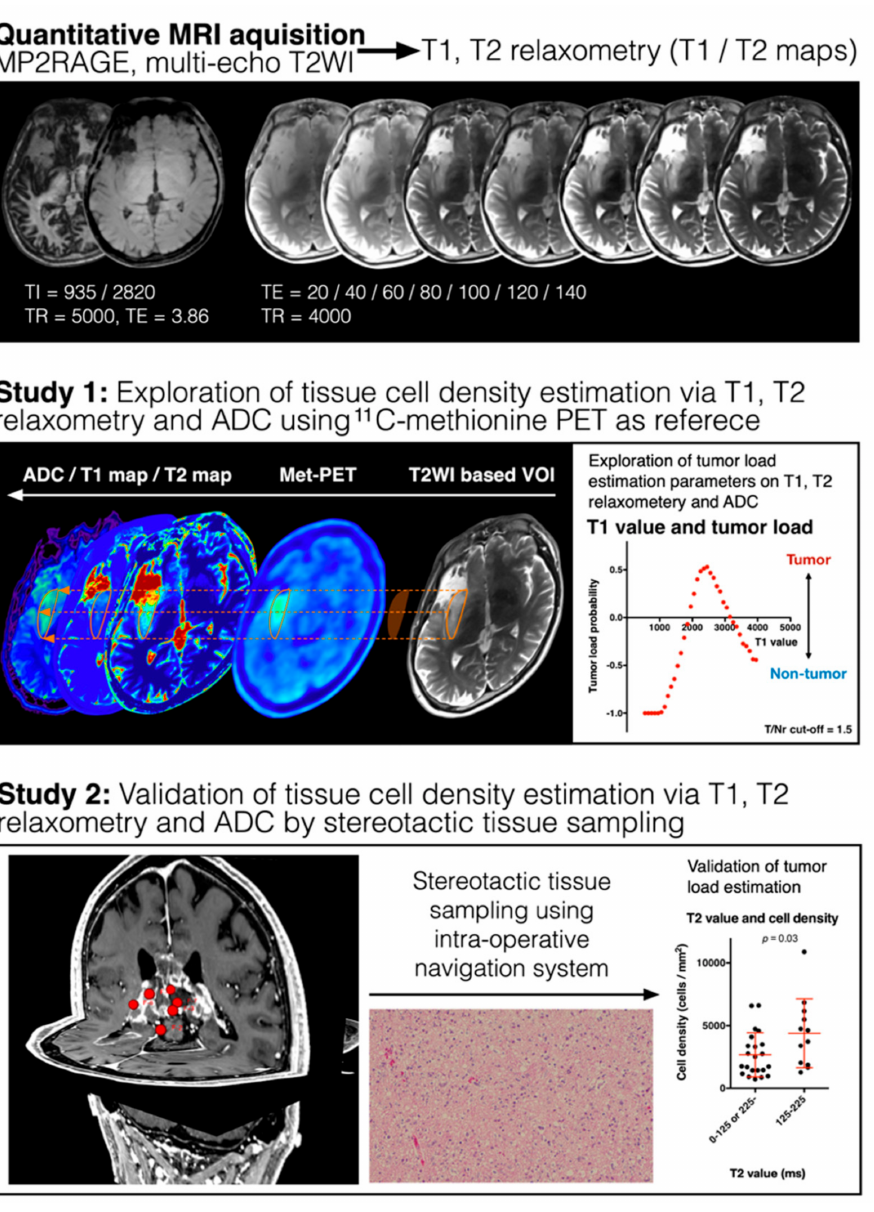
Figure 1. Analytical workflow of the present study. Bayesian inference modeling was utilized to convert MP2RAGE images and multi-echo T2-weighted images to T1-relaxometry and T2-relaxometry. The current study was carried out in two stages: Stage 1, investigating the correlation between T1- or T2-relaxation time and apparent diffusion coefficient (ADC) and 11 C-methionine uptake as measured by positron emission tomography (Study 1), and Stage 2, comparing T1- or T2-relaxation times and ADC with tumor cell density as measured by stereotactic image-guided tissue sampling (Study